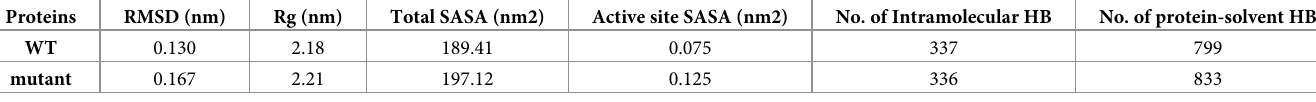
Table 1. The average of various parameters during 100-ns MD simulation of wild type and mutant ARSAs. Proteins RMSD (nm)